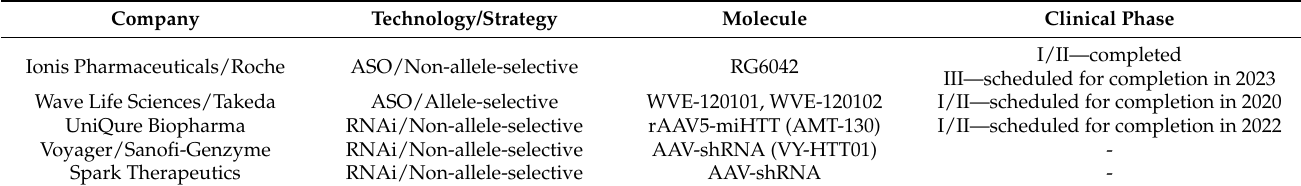
Table 1. Pharmaceutical company-tested therapeutic strategies for Huntington’s disease (HD), using molecules that target huntingtin mRNA that are in clinical testing or close to the start of this phase.